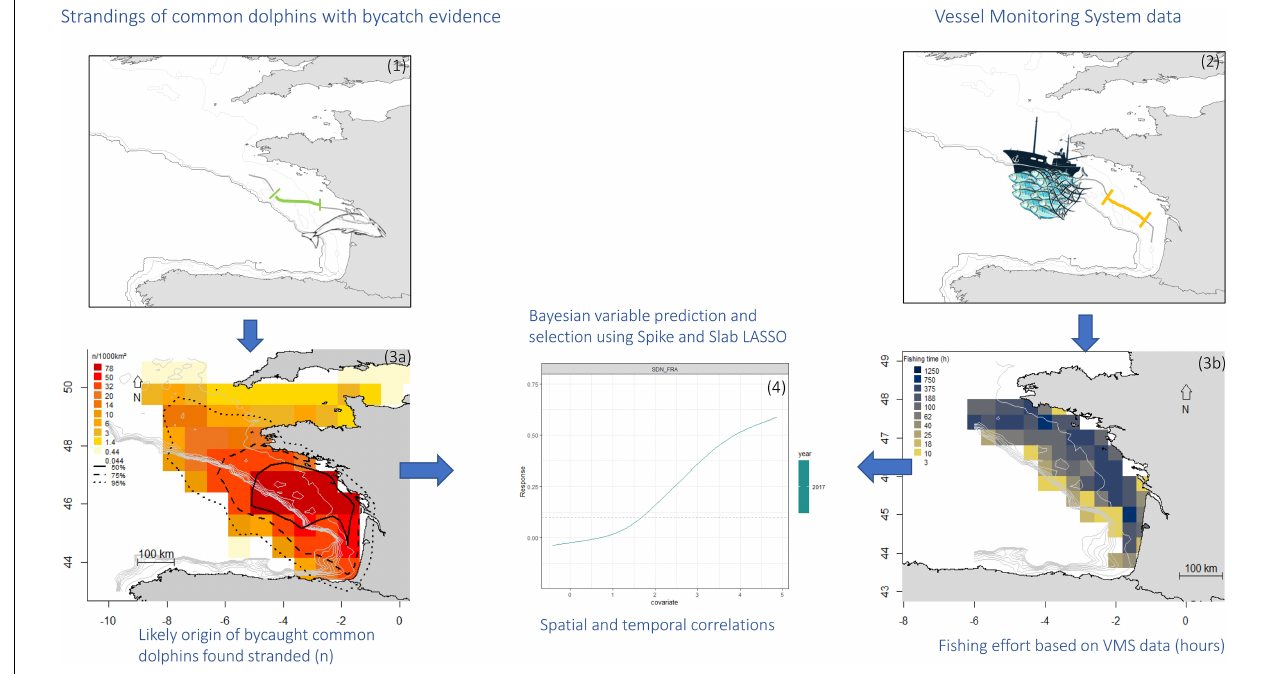
FIGURE 3 | Schematic representation of methodology used. UME, unusual mortality event; VMS, Vessel Monitoring System. (1) Reverse trajectory of stranded dolphins; (2) Inferred trajectory of fishing vessel; (3a) Origin of bycaught dolphins found stranded during a UME (n); (3b) Fishing effort at the time of UME (hours); (4) Bayesian variable prediction and selection using spike-and-slab LASSO | Spatial and temporal correlations.